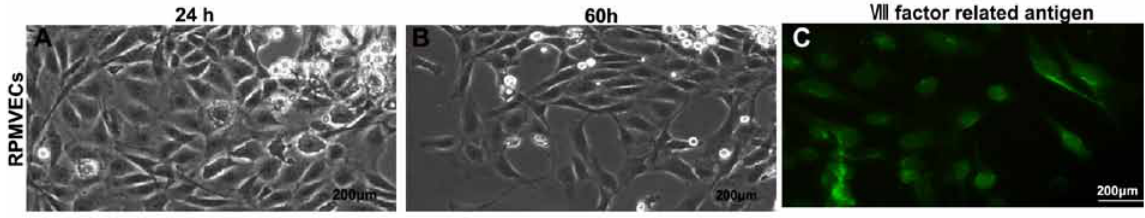
Figure 1. Identification of RPMVECs. A: The shape of RPMVECs at 24 hours in ordinary microscope; B: The shape of RPMVECs at 60 hours in ordinary microscope; C: The immunofluorescence staining of the VII factor related antigen in